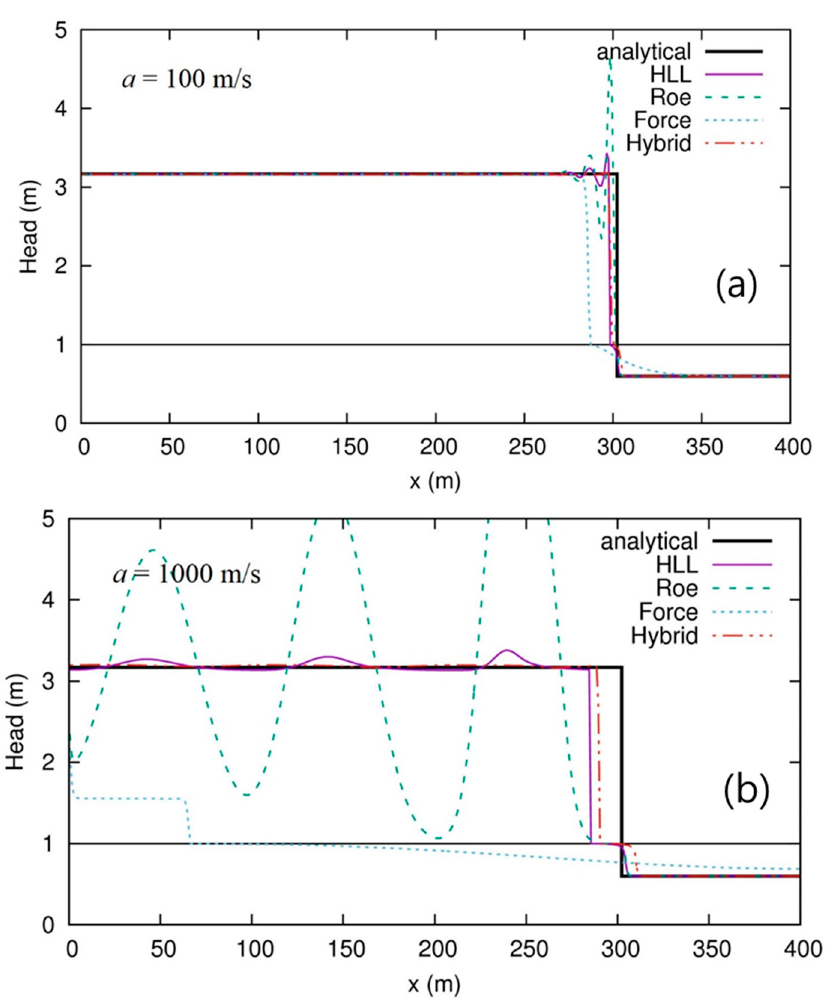
Figure 2. Comparison of results computed by different flux schemes for a typical filling bore problem (Test 1) with ( a ) a = 100 m/s; ( b ) a = 1000 m/s.